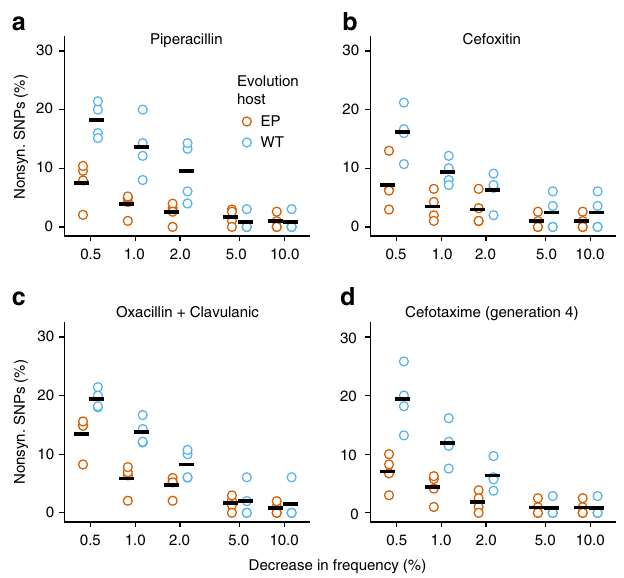
Figure 4 | Percentage of deleterious nonsynonymous SNPs in populations after three generations of evolution. The analysis is based on all nonsynonymous SNPs, except the strongly sweeping E104K, M182Tand G238S, and shows the percentage of SNPs (vertical axis) that decreases in frequency by at least a given amount (horizontal axis) after a single additional generation of selection on ( a ) piperacillin, ( b ) cefoxitin and ( c ) oxacillin with clavulanic acid in wild-type hosts. ( d ) The percentage of SNPs that decreases in frequency by a given amount after selection of cefotaxime (‘generation’ 4 of the evolution experiment). Black lines correspond to the mean across four replicate